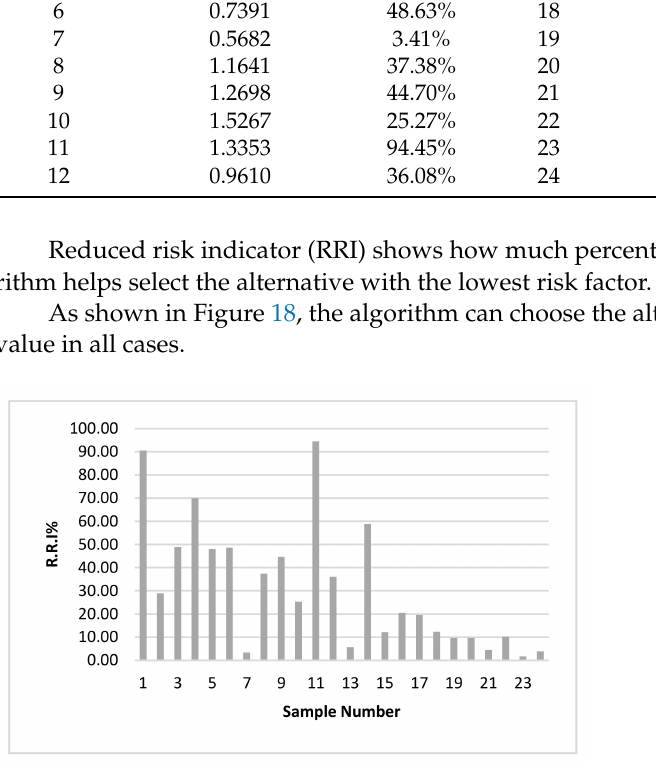
Figure 18. The results of the RRI% index for the solved case studies.